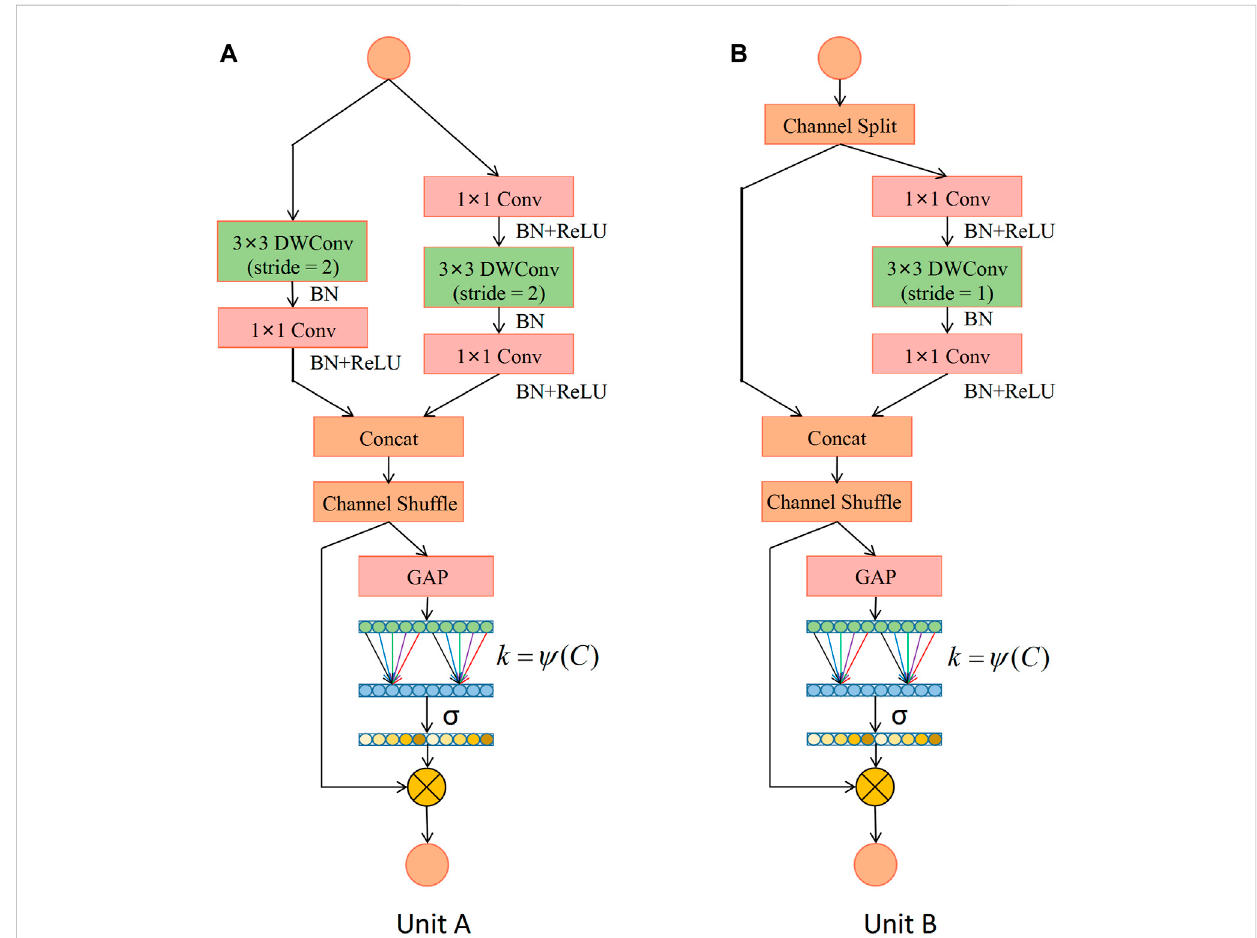
FIGURE 5 Detailed description of the ECA-Shuf fl e unit. (A) Unit A: the basic unit for spatial down sampling; (B) Unit B: the basic unit for channel split. Notes: DWConv: Depthwise separable convolution; Conv: convolution; BN: Batch Normalization; GAP: Global Average Pooling.